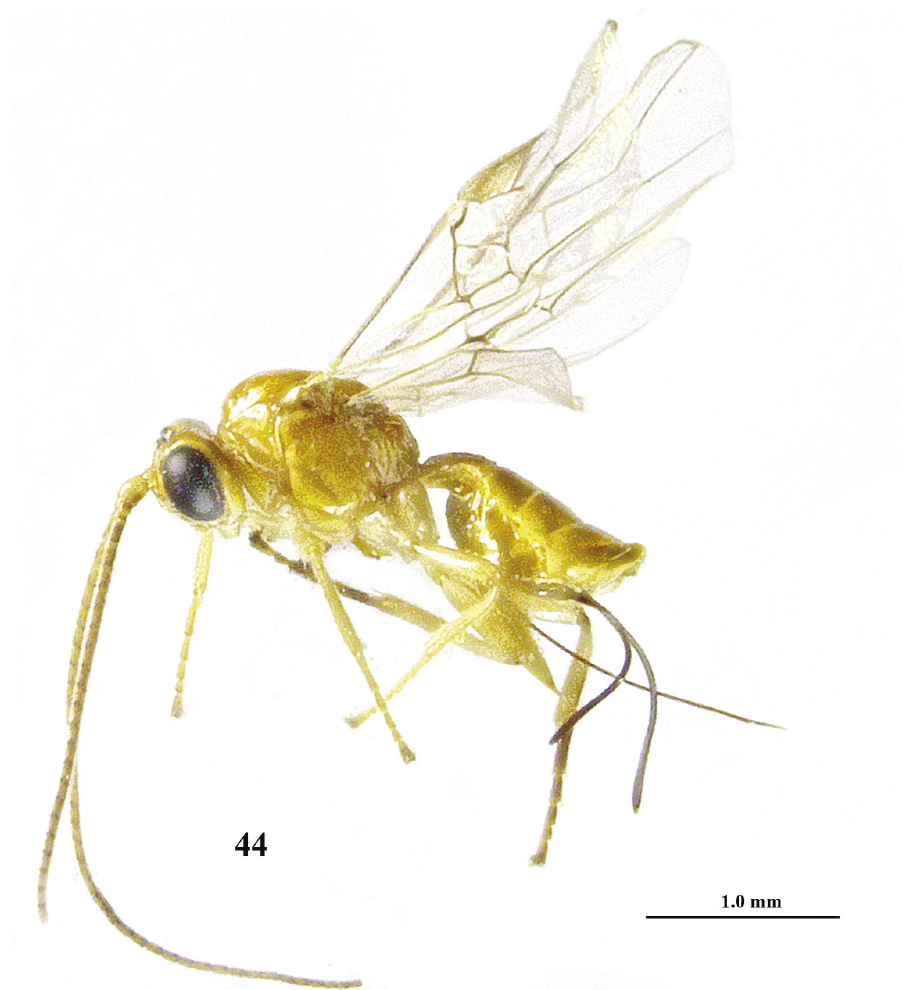
Figure 44. Psyttalia majocellata sp. n., ♀ , holotype, habitus lateral. Head . Antenna with 40+ segments (apical segments missing), bristly and rather erect setose and at least 1.3 times as long as fore wing; third segment 1.2 times as long as fourth segment, length of third and fourth penultimate segments 3.2 and 2.6 times their width, respectively (Fig. 44); maxillary palp 1.1 times as long as height of head; length of eye in dorsal view 3.9 times temple (Fig. 50); temple shiny, smooth except for some punctulation posteriorly and with sparse setae; OOL: diameter of ocellus: POL = 22:13:13; area behind stemmaticum reclivous (Fig. 50); face coarsely punctate with interspaces about equal to diameter of punctures and with satin sheen (Fig. 49); frons slightly depressed behind antennal sockets and with triangular depres- sion between antennal sockets, shiny, smooth and glabrous but laterally (as